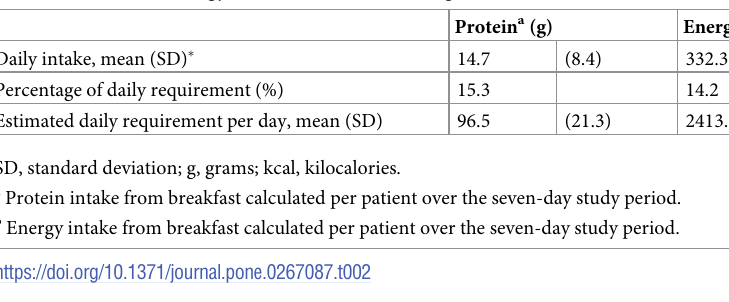
Table 2. Protein and energy intake of the cohort during breakfast. Daily intake, mean (SD) � Percentage of daily requirement (%) Estimated daily requirement per day, mean (SD)